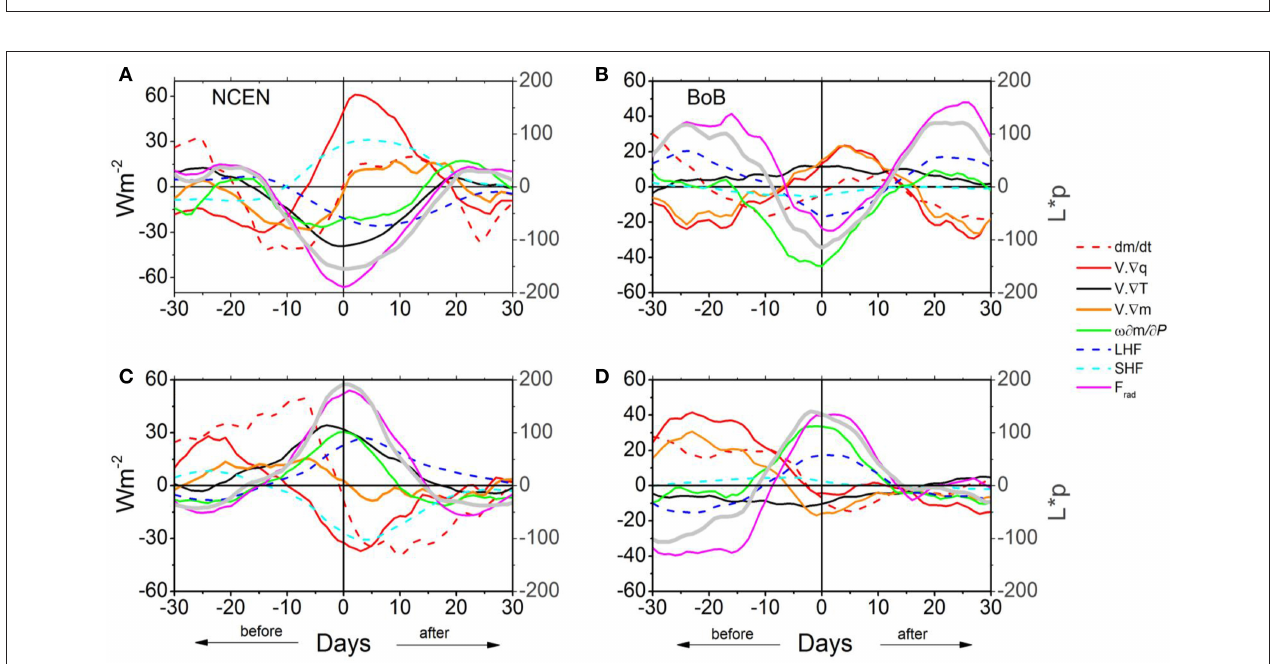
FIGURE 12 | Same as Figure 11 , but for the composites during extended monsoon episodes over NCEN and BoB.